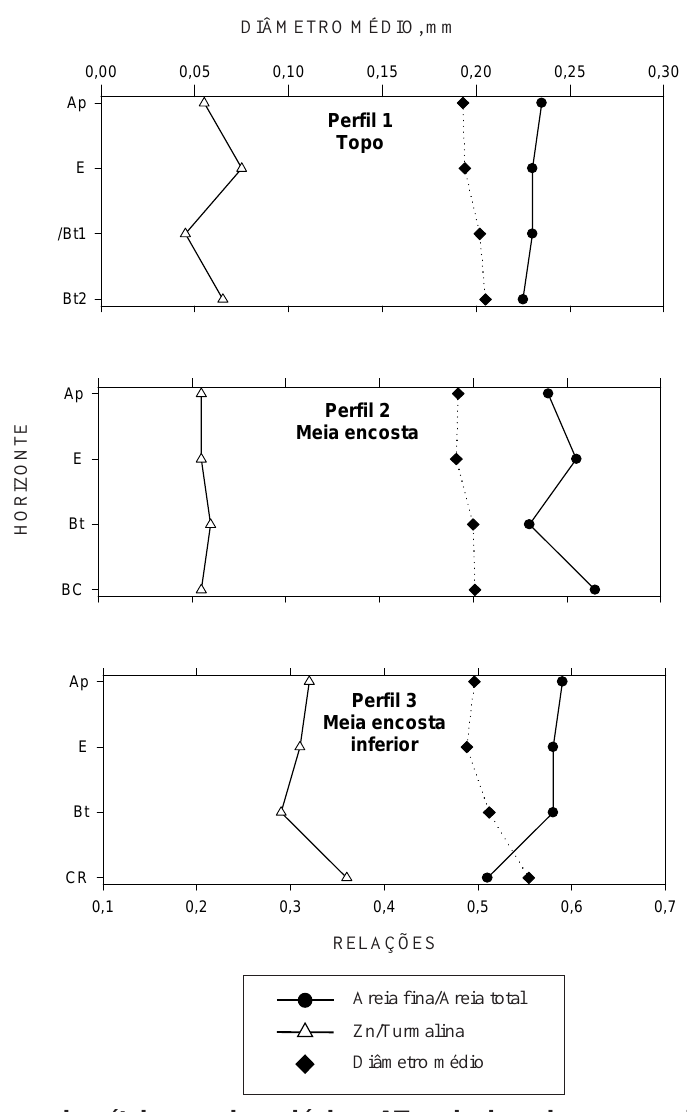
Figura 5. Atributos granulométricos e mineralógicos AT= relacionados com a uniformidade dos materiais do solo. AF/AT = relação areia fina/areia total; Zr/Tur. = relação zircão/turmalina; Diâm. médio = diâmetro médio das areias